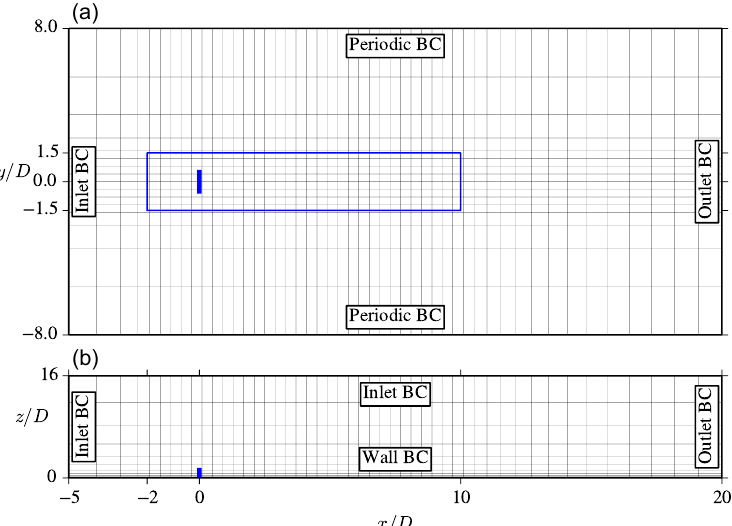
Figure 3. Grid and boundary conditions of the single-AD simulation. Every fourth grid line is plotted. (a) Top view of the grid. (b) Side view of the grid. Blue filled box represents the AD. The horizontal spacing inside the blue rectangle is set to D/